Question: Produce a descriptive caption suitable for publication.
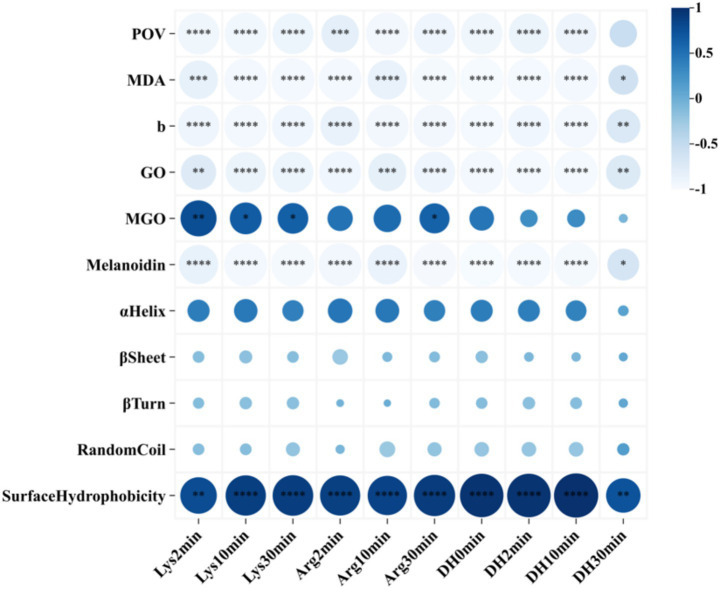
Answer: Pearson correlation analysis of lipid oxidation, non-enzymatic glycation, milk protein structure index and degree of protein hydrolysis of milk.